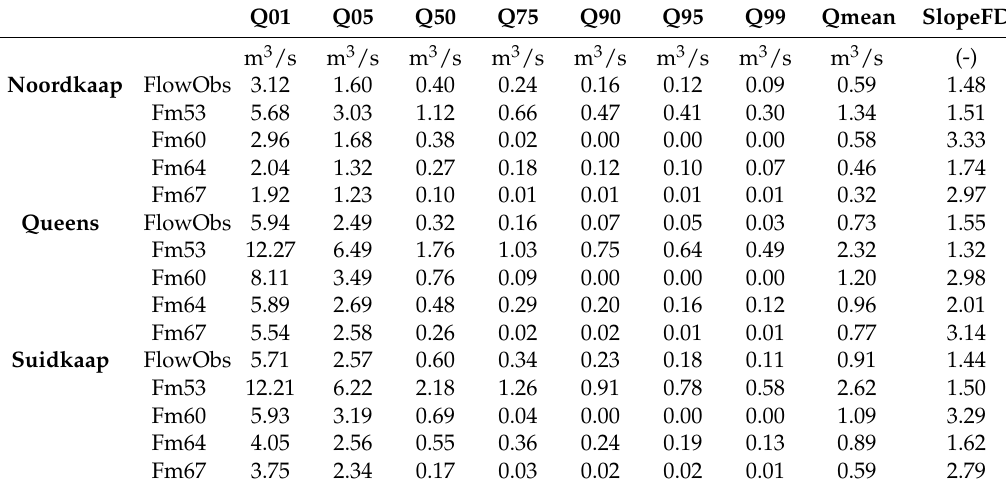
Figure 7. Flow duration curve for the four catchments, using results of run 64. Table 7. Quantiles of high and low flow, and slope of flow duration curve (between Q30 and Q70) for the different model runs compared to observed flow (FlowObs).